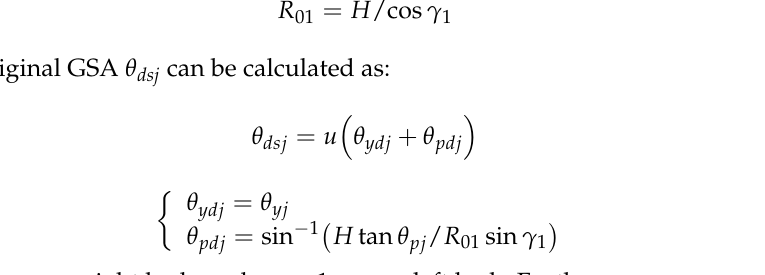
where θ rj is the roll angle, which is equal to the look angle, and θ pj and θ yj are the original pitch and yaw angle. Expressions about these two angles are presented in [37]. The look angle is assumed to be consistent before and after attitude steering.